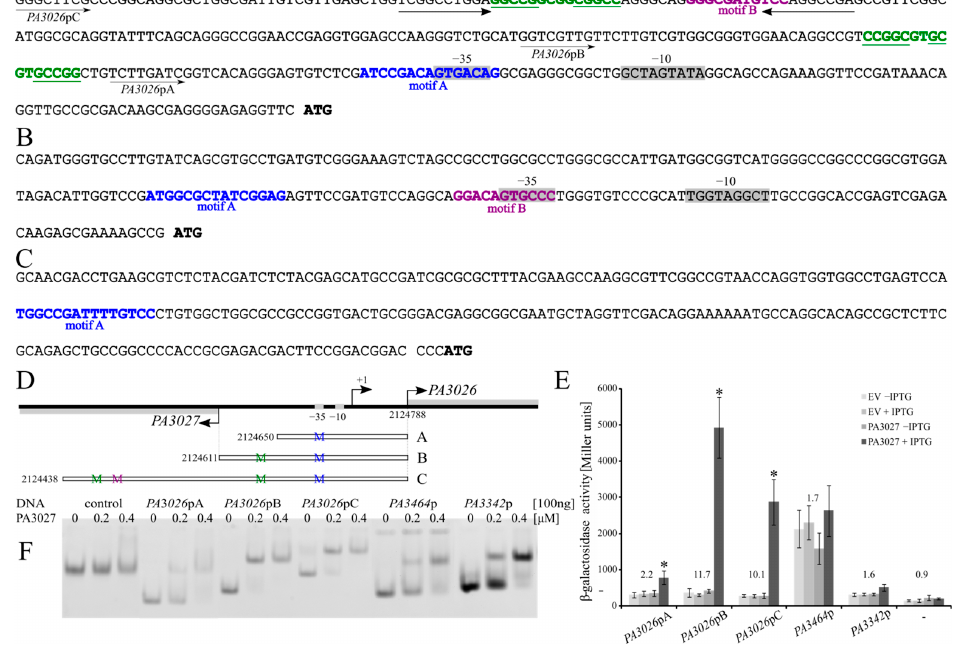
Figure 4. PA3027 interaction with DNA assayed in vivo and in vitro. ( A – C ) Putative PA3027 binding motifs in PA3026 ( A ), PA3464 ( B ), and PA3342 ( C ) promoter fragments, used in β -galactosidase activity assays and electrophoretic mobility shift assay (EMSA) analysis. Blue—motif A, violet—motif B, green—pseudoplindrome, grey—“ − 10” and “ − 35” promoter regions. ( D ) The scheme of variants of the PA3026–PA3024 promoter used in the analysis and cloned to pCM132 upstream of a promoter-less lacZ reporter gene. ( E ) Influence of PA3027 on the activity of PA3026 p, PA3464 p, and PA3342 p. β -galactosidase activity in extracts from E. coli DH5 α ∆ lac cells bearing pCM132 derivatives containing the indicated promoters upstream of lacZ as well as pKKB1.11 ( tac p-PA3027), allowing IPTG inducible PA3027 production or empty vector pAMB9.37